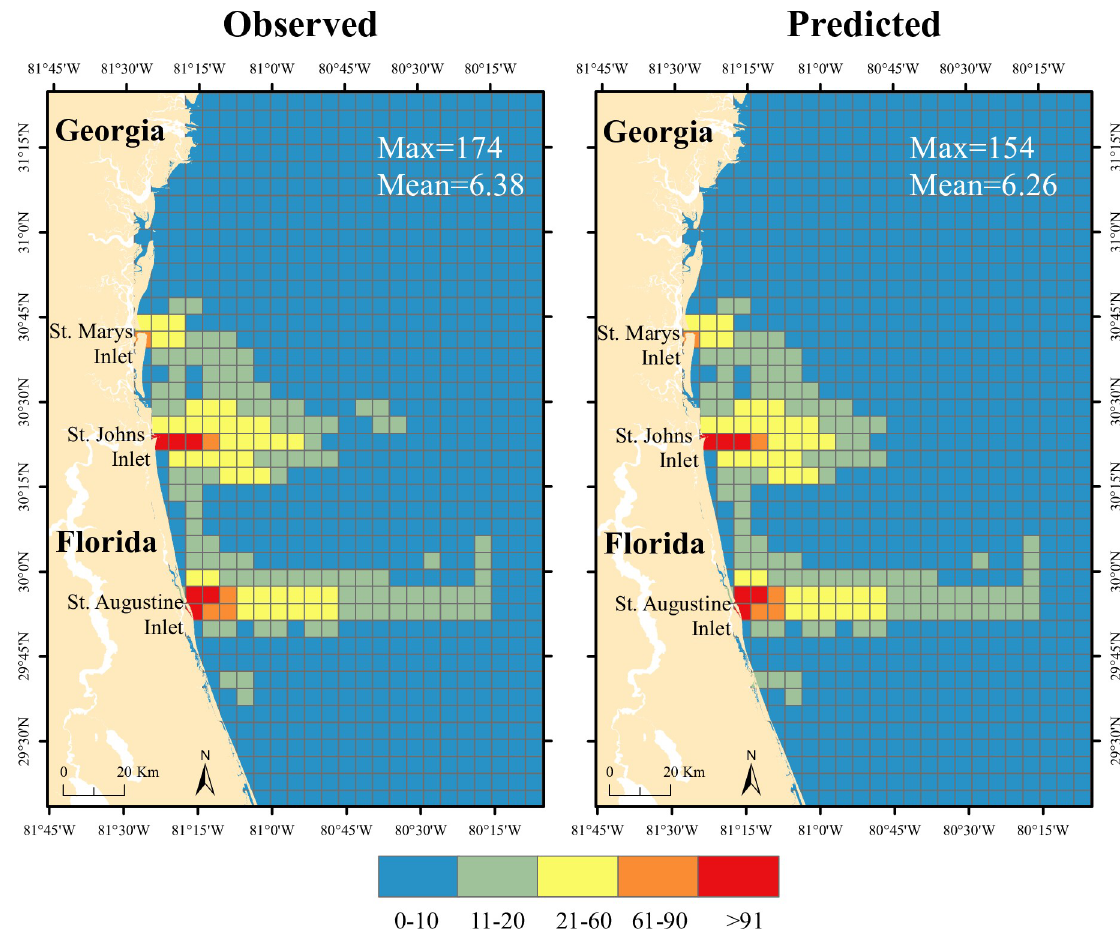
Fig 5. Presence/absence and predicted offshore recreational boating trip abundance for the winter season from the